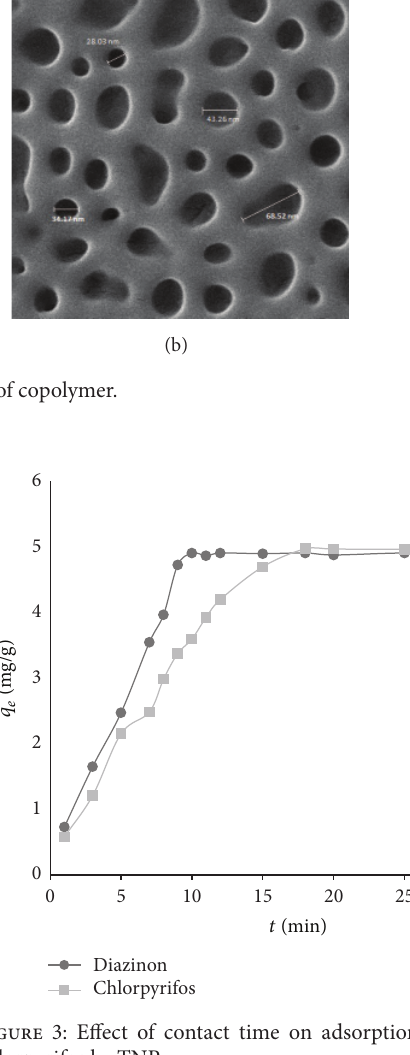
Figure 2: Effect of pH on adsorption of diazinon and chlorpyrifos by TNP.